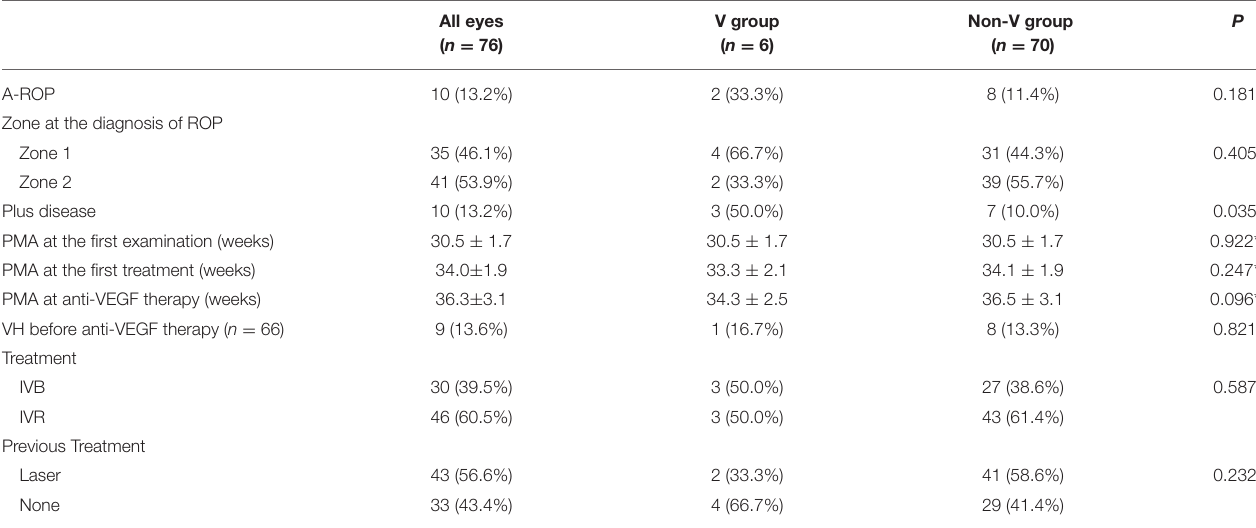
TABLE 2 | Ocular characteristics of the study